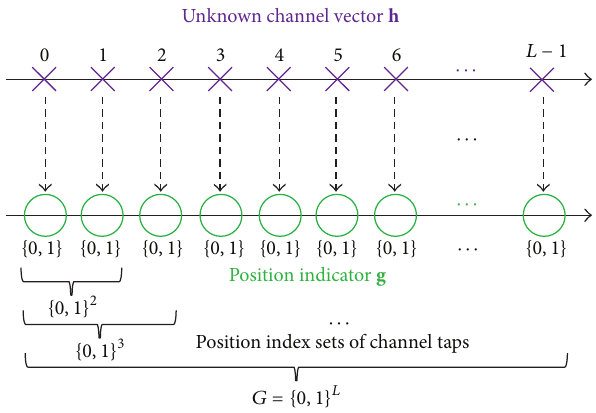
Figure 3: Graph illustration for all of possible position index sets of channel